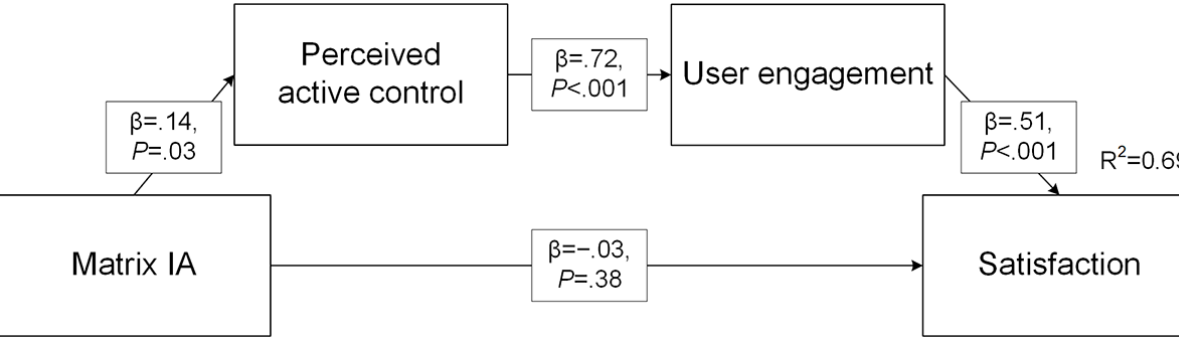
Figure 6. Serial mediation model of matrix information architecture effects on satisfaction via active control and engagement. IA: information architecture.